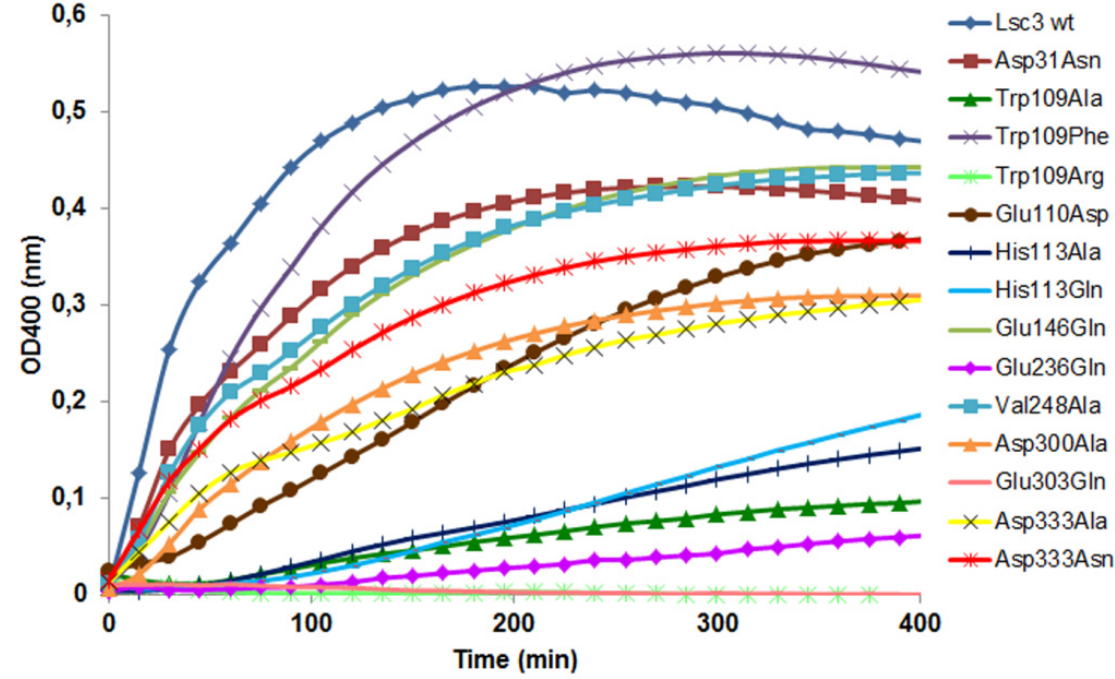
Figure 6. Time course of levan synthesis by the wild-type Lsc3 protein (Lsc3 wt) and fourteen mutants. Reaction was conducted at 37 °C on flat-bottom polystyrole microplates in total volume of 200 μ L per well. Reaction mixture contained 600 mM of sucrose in McIllvaine’s buffer (pH 6.0) and 10 μ g/mL of purified protein. Increase of turbidity was measured at 400 nm every 15 min using Infinite M200 PRO microplate reader. Mean values of four parallel measurements are shown. Standard deviation was less than